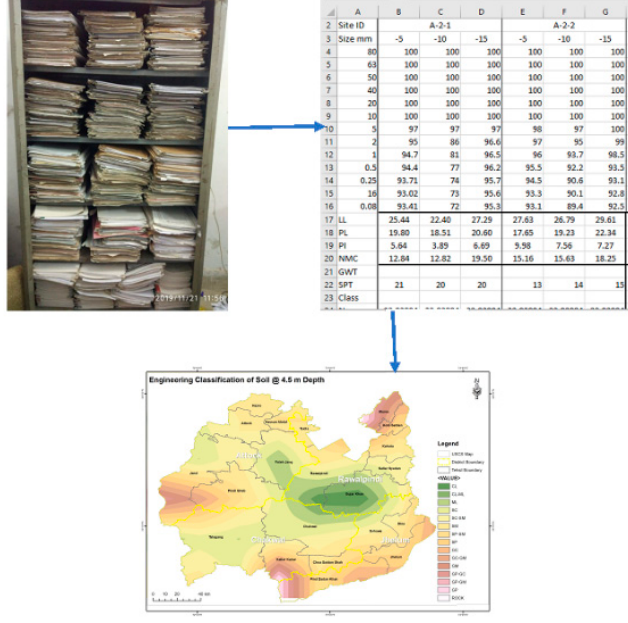
Figure 2. Data Transformation.